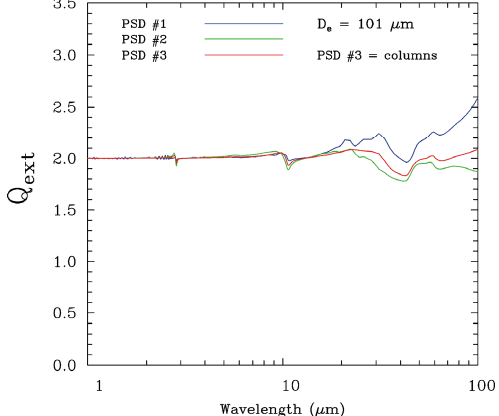
Figure 11. Experimental design for the Arctic cirrus case study, based on the mean PSD sampled during ISDAC between -35 and -40 o C (blue curve). The other two PSD were derived from a PSD scheme based on midlatitude cirrus data, evaluated at the indicated temperatures. The green curve contains approximately the same ice particle shapes (in terms of their mass and area attributes) as the measured PSD, while the red curve contains only hexagonal columns. All PSD are having the same D e and IWC.